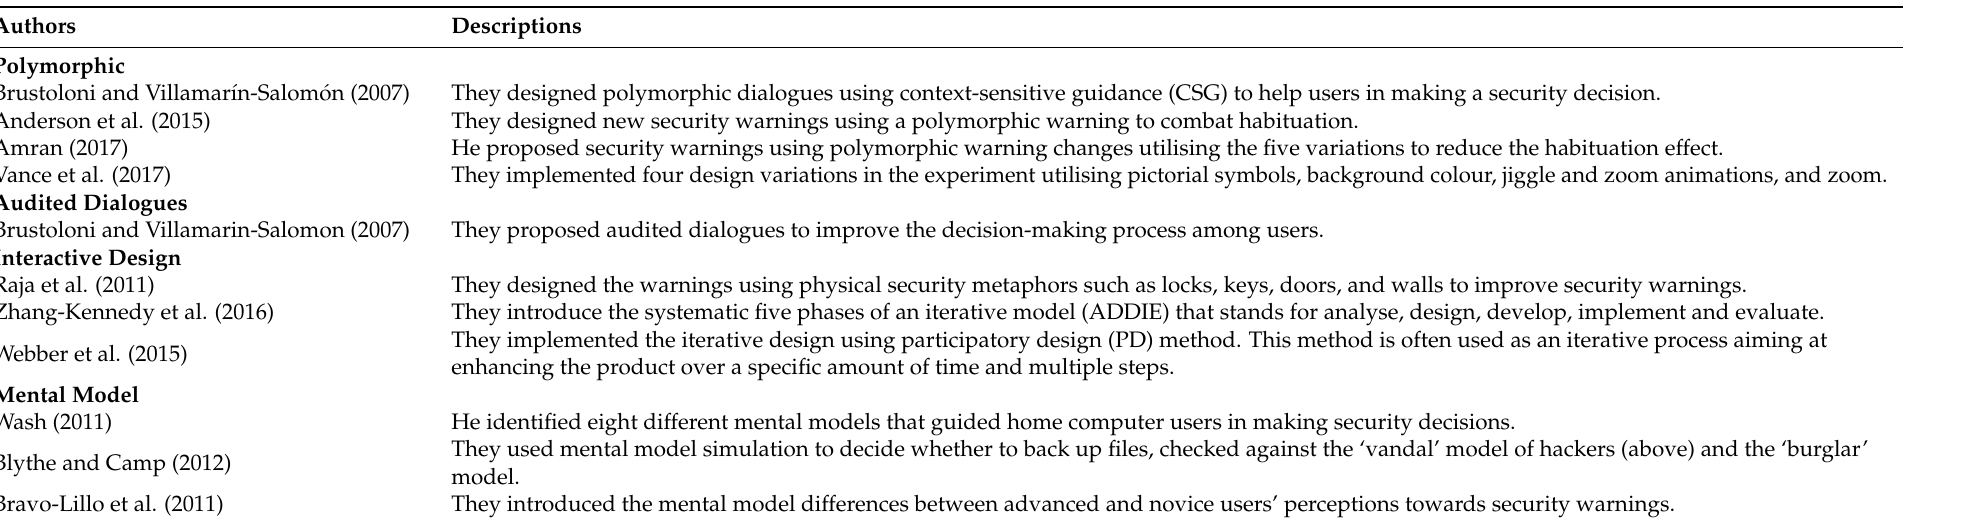
Table A2. Summary of approaches to improving security